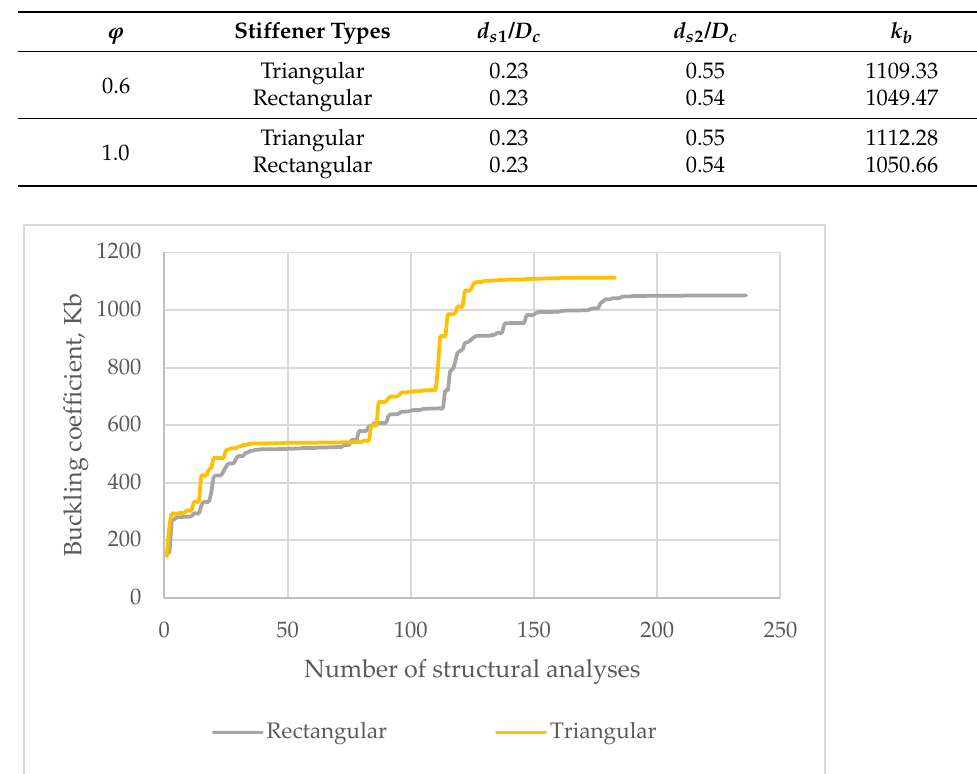
Figure 7. Convergence history for stiffeners with closed cross-section shapes.